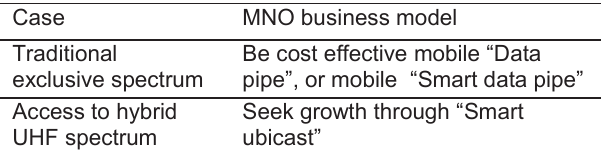
Table 1. Summary of Developed Business Models.